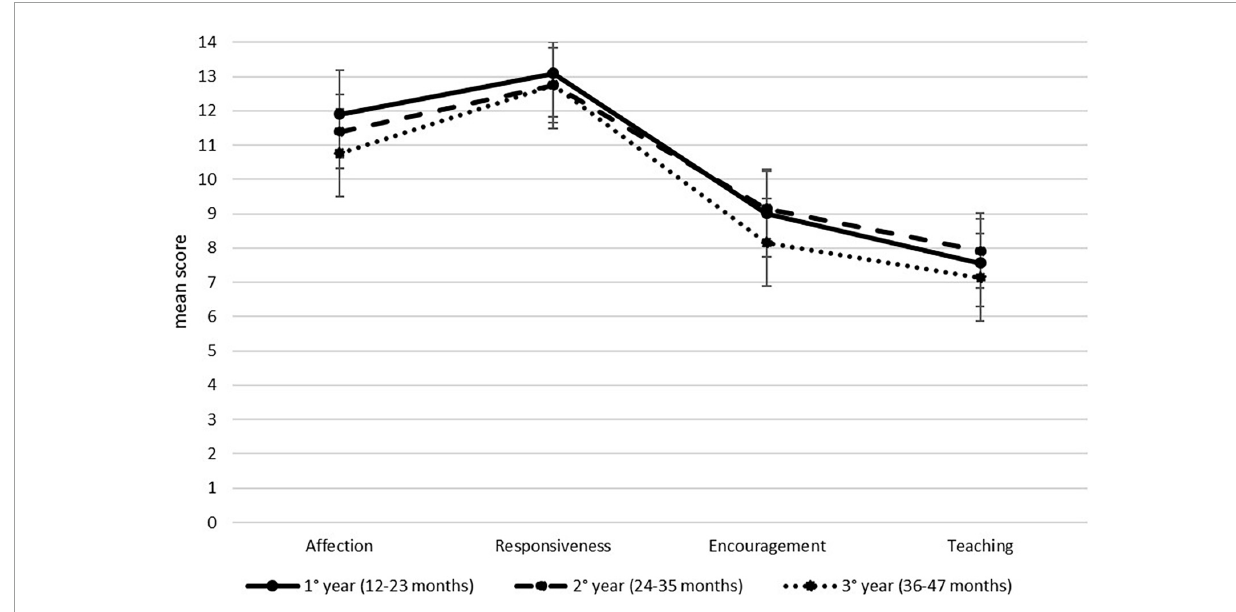
FIGURE1 Parenting Interactions with Children: Checklist of Observations Linked to Outcomes (PICCOLO) domains in the three age groups.